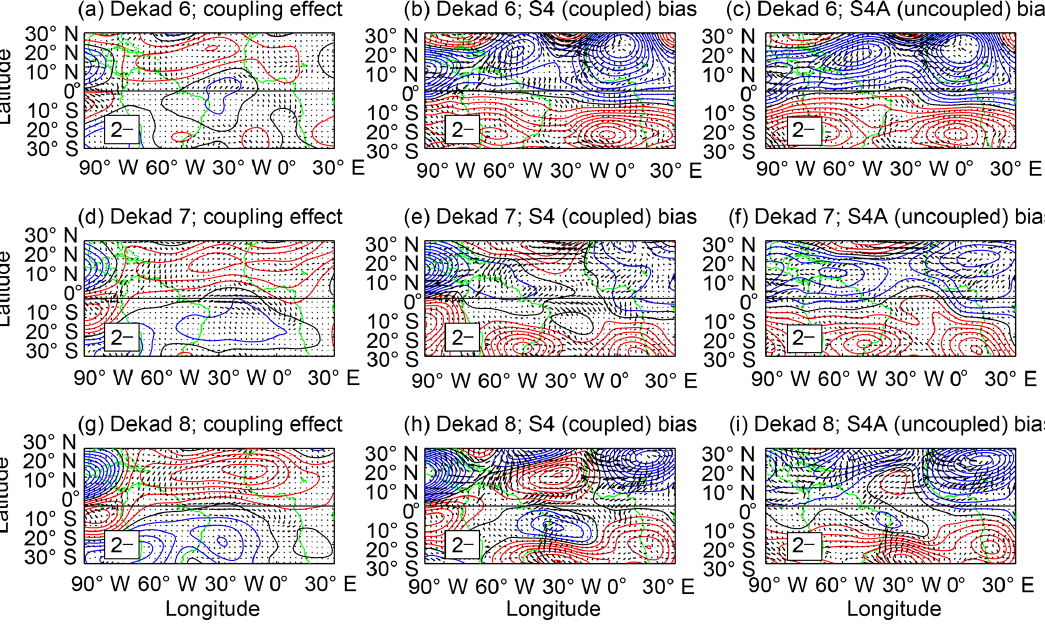
Figure 9. Maps of dekad-mean biases in 10m wind vector (black arrows, in ms − 1 ) and 200hPa streamfunction (contours). The middle column shows the coupled biases in S4; the right column shows the uncoupled biases in S4A; the left column shows the coupling effect (S4 minus S4A) for dekads 6 to 8. Positive streamfunction bias contours are red, negative contours are blue and the zero contour is black. North of the Equator, red contours are anticyclonic and blue contours are cyclonic. Dekads are counted from initialisation on 1 February.